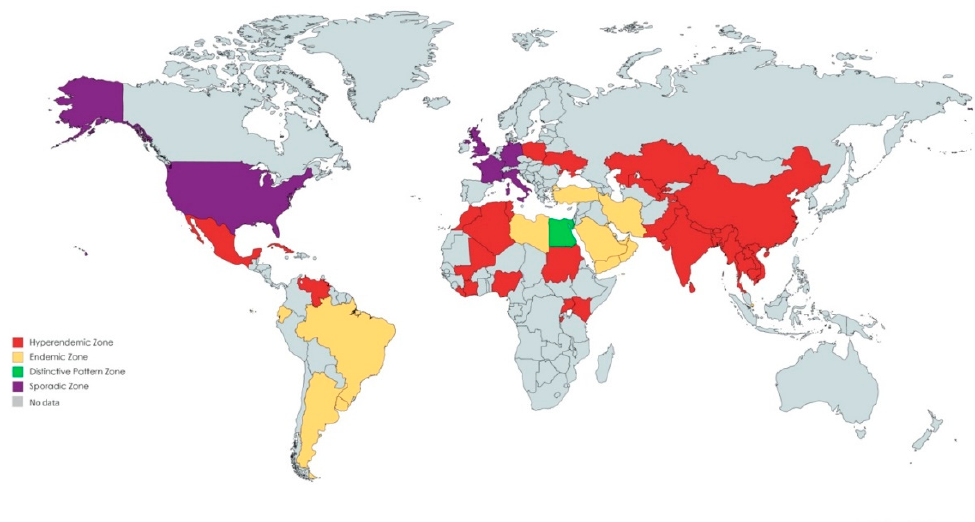
Figure 4. Hepatitis E epidemiology in 4 distinctive zones.